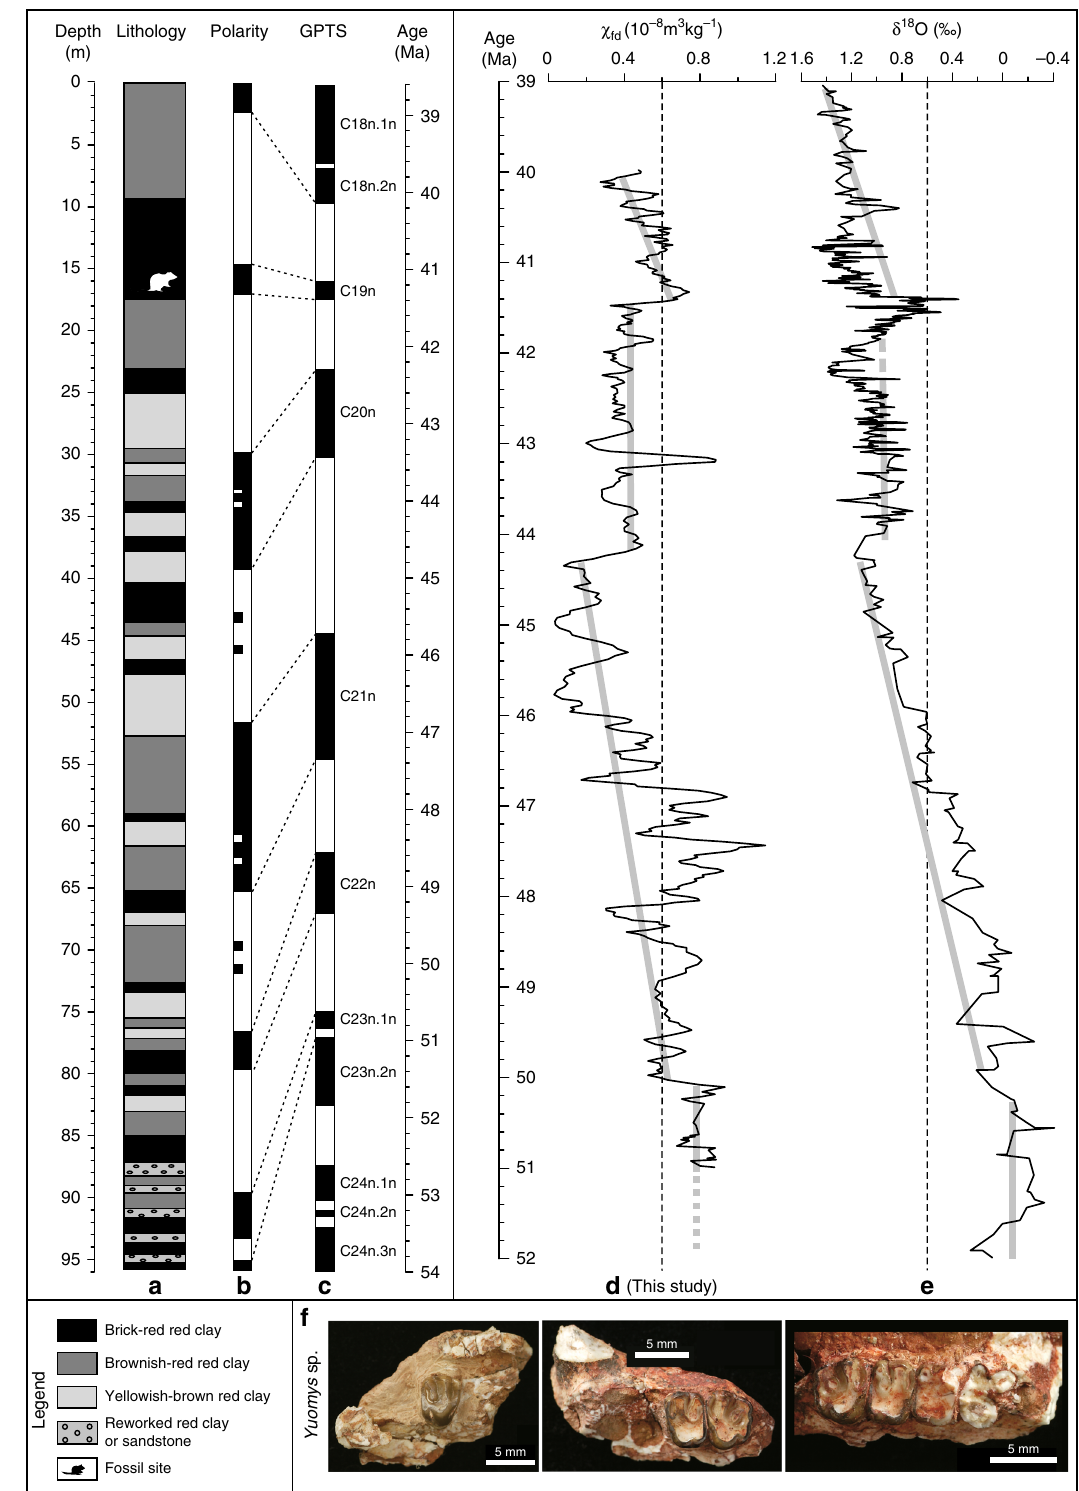
Fig. 3 Magnetostratigraphy and frequency-dependent magnetic susceptibility for the studied red clay sequence. a Lithology, b magnetic polarity stratigraphy for the studied Xishuigou section, Altun Shan, and correlation with c the geomagnetic polarity timescale (GPTS) 29 . Polarity: black = normal, white = reversed. Each plotted palaeomagnetic direction was obtained by principal component analysis of detailed stepwise thermal demagnetisation data. d , e Correlation between d the frequency dependence of low- fi eld magnetic susceptibility χ fd of Altun Shan red clay and e the δ 18 O record of ref. 32 . The χ fd record re fl ects pedogenic formation of fi ne magnetic particles, which depends strongly on soil moisture. It is, therefore, a good proxy for precipitation/ aridity 31 . The long-term χ fd trend and recording of humid events such as MECO at ~40 – 41 Ma (see main text) correlate well with the global climate record of ref. 32 and support the age model presented. Minor discrepancies in the positions of events in d and e largely re fl ect imprecision in the respective age models. f Photographs of extinct Eocene Yuomys altunensis rodent jawbones are shown at the base of the fi